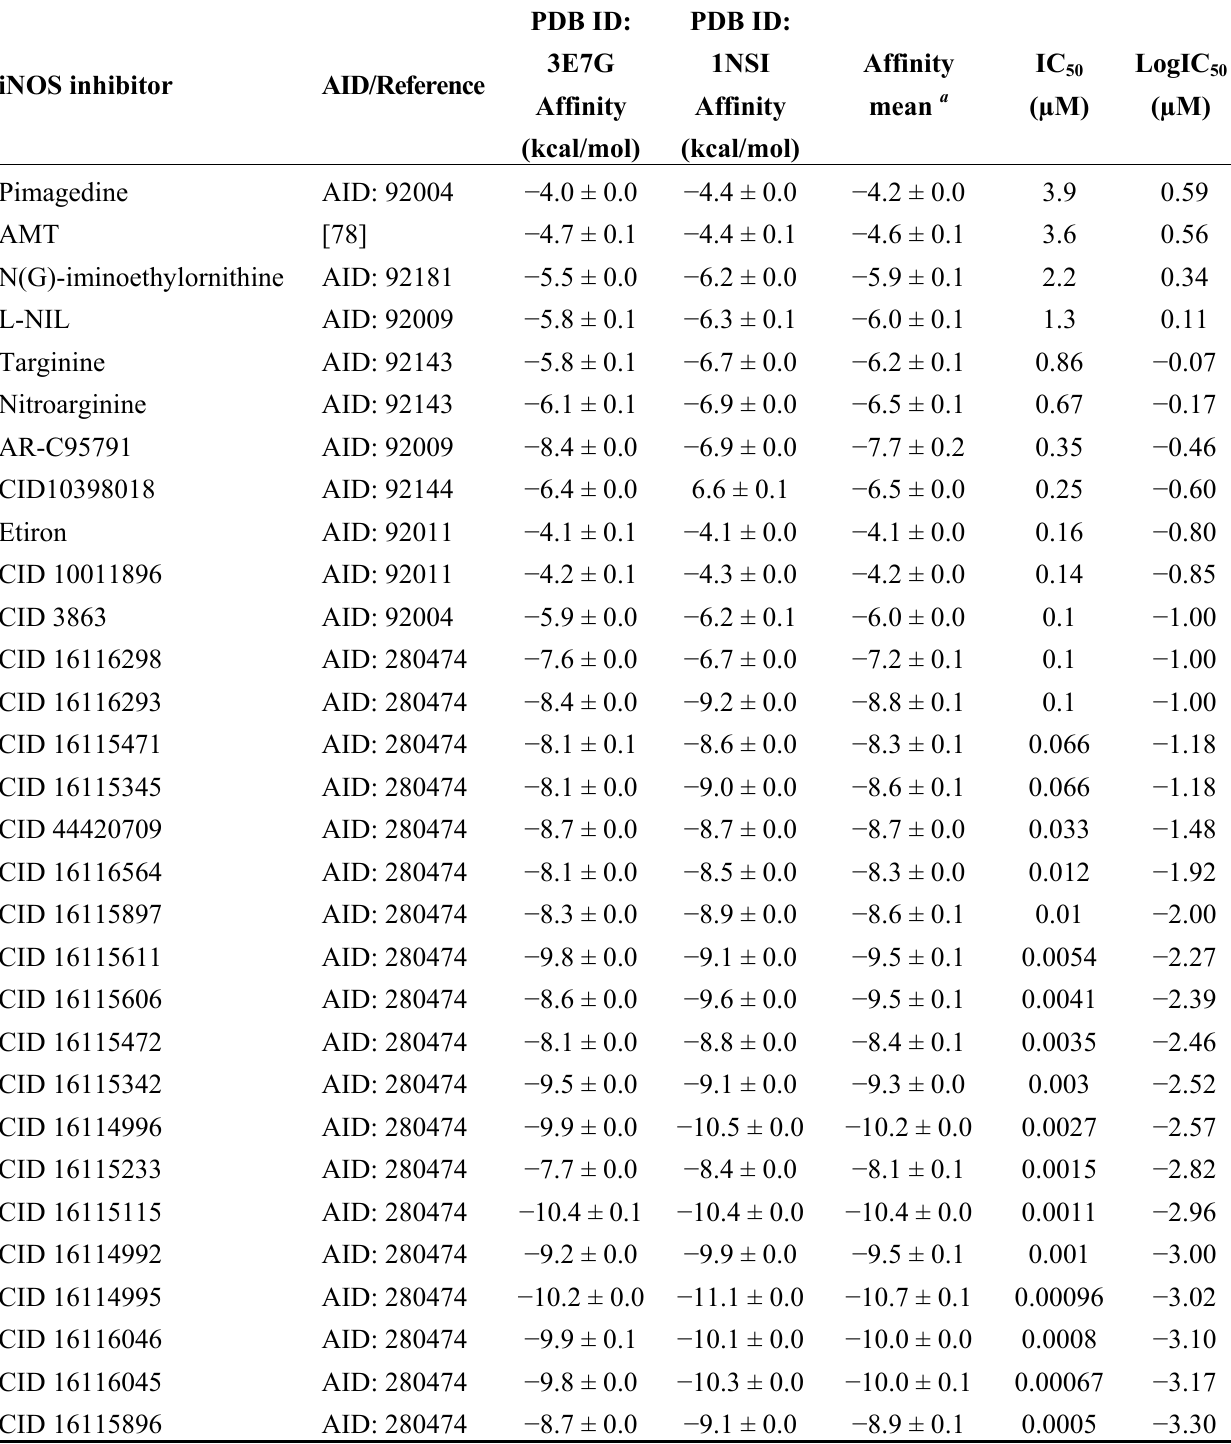
a Average affinity between the scores obtained for two iNOS structures (PDB ID: 3E7G and PDB ID: